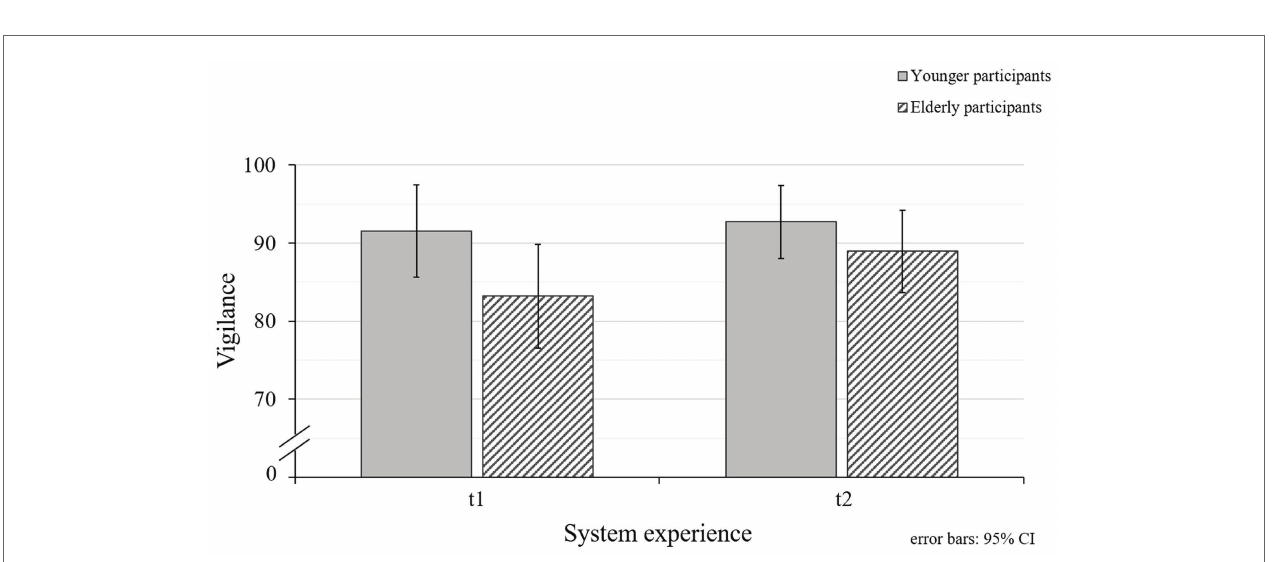
FIGURE 9 | Mean values for younger and elderly participants’ vigilance toward the eHMI for the different points of measurement (t1 = valid system functions; t2 = valid and invalid system functions). Higher values represent higher indicated vigilance toward the system.